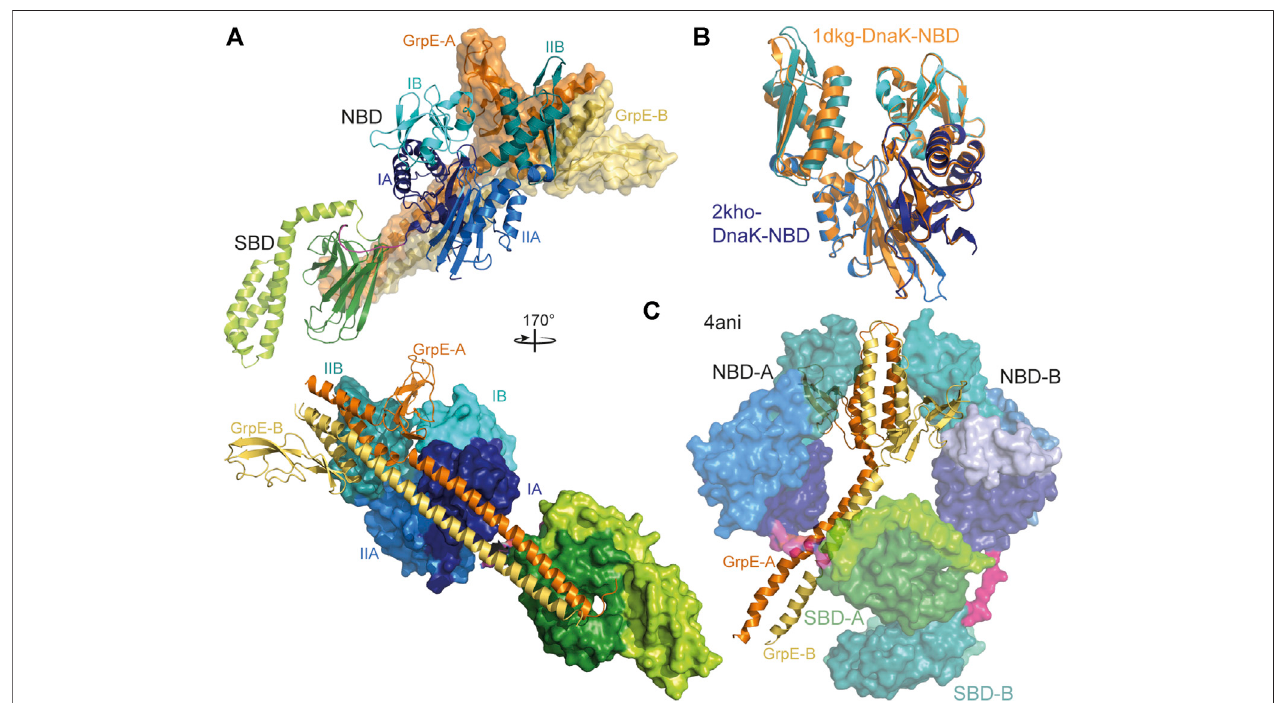
FIGURE5| InteractionofGrpEwithDnaK. (A) ,overlayofthecrystalstructureof E.coli GrpEincomplexwiththeNBDof E.coli DnaK[1DKG,(Harrisonetal.,1997)] onto the solution structure of E.coli DnaK inthe ADP-bound conformation[2KHO,(Bertelsen et al., 2009)].Top panel, DnaKas cartoon, GrpE insurface representation. Bottom panel, rotated by 170 ° as compared to the top panel and DnaK in surface representation and GrpE as cartoon. (B) , overlay of the NBD of E. coli DnaK in the absence (colored different shades of blue according to subdomains) and presence (orange) of GrpE indicating the 14 ° outward tilt of subdomain IIB. (C) , crystal structure of two molecules of Geobacillus kaustophilus DnaK (surface representation) in complex with the GrpE dimer